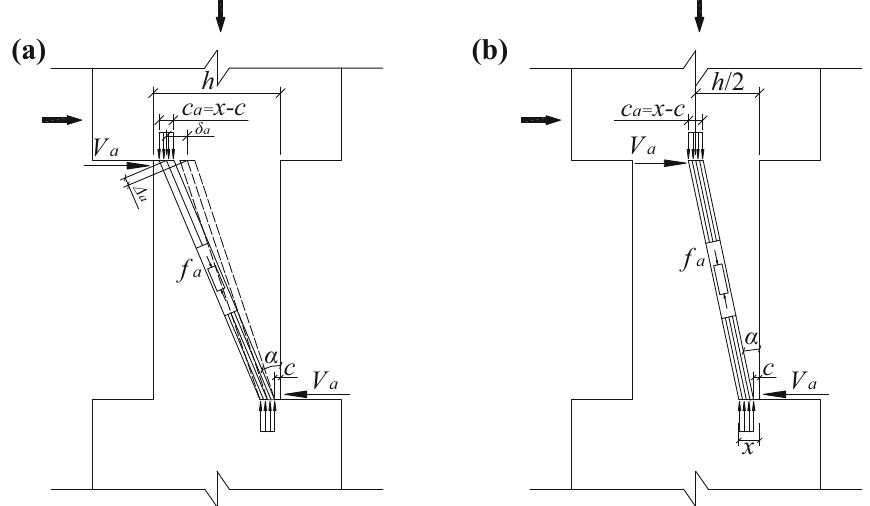
Fig. 4 Diagram of arch action. a column with fixed–fixed ends b column with fixed pinned ends.